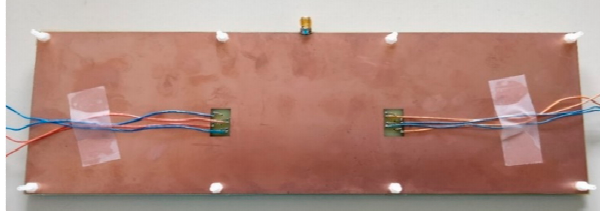
Figure 19 . Bottom view of the P-ESPAR antenna.